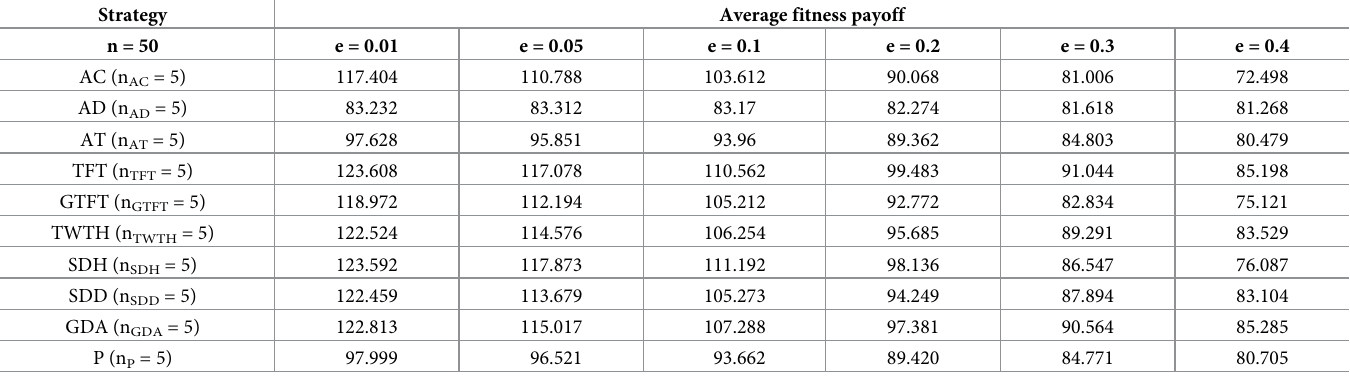
Table 2. The average fitness payoff for ten strategies competing in a group under the conditions that group size is 50 ( n = 50), benefit equals 1 and cost equals 0.25 ( b = 1 and c = 0.25).